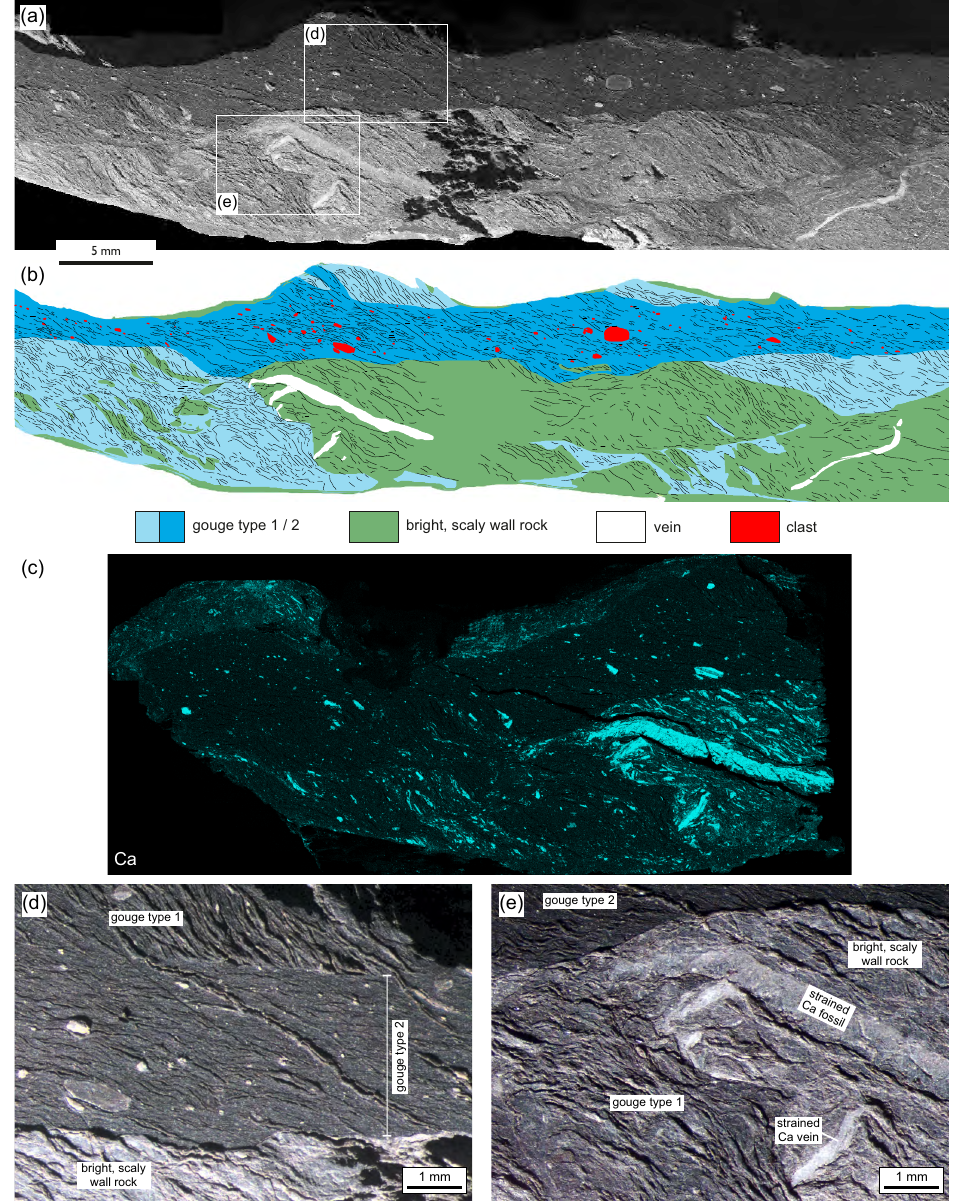
Figure 4. Illustration of (i) the sharp gouge (dark) to wall rock (bright scaly clay) contact, (ii) the distinct boundary between types 1 and 2 gouge, (iii) the gouge-internal P foliation and (iv) gouge-internal clasts, and (v) surrounding calcite veins. (a) Shaded light photograph of water-immersed hand specimen V15 with (b) sketch and (c) SEM-EDX Ca distribution map of the sample. Note that gouge is drastically reduced in Ca compared to scaly wall rock. Panels (d) and (e) are insets of panel (a) . See text for